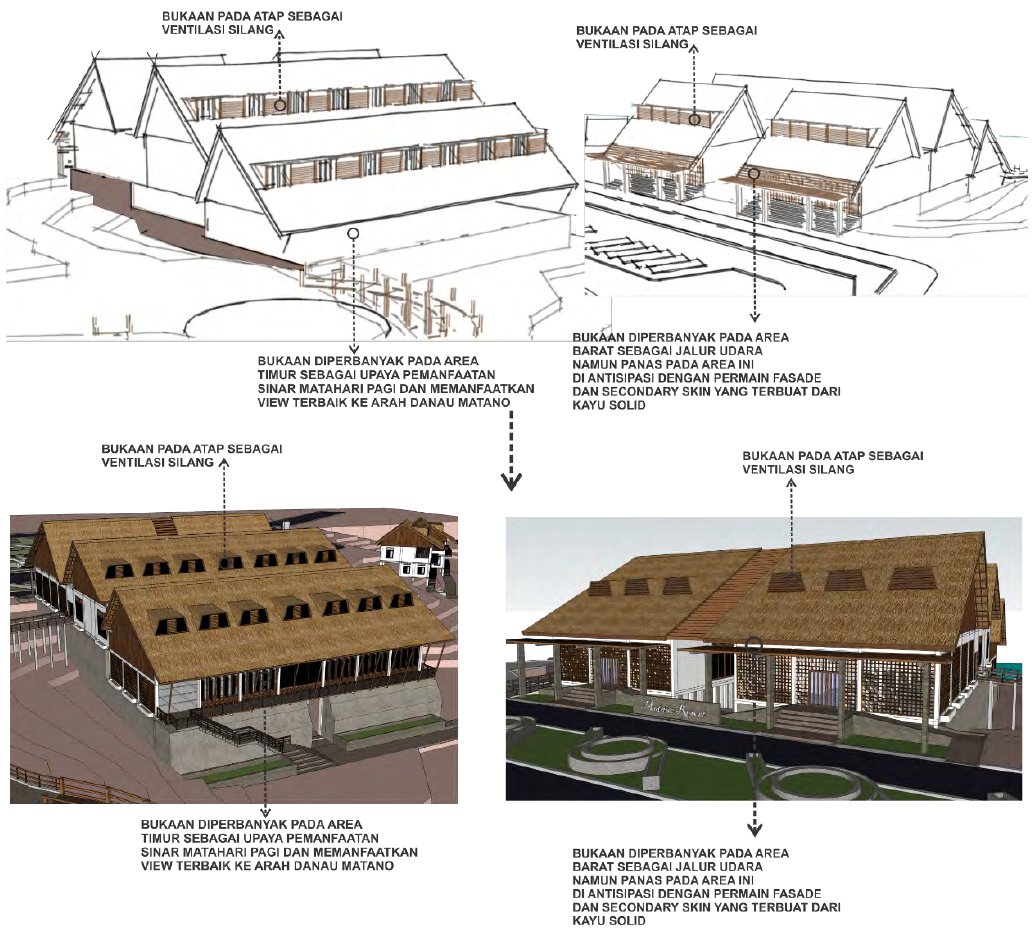
Figure 3. The utilization strategy on natural energy for building illumination and